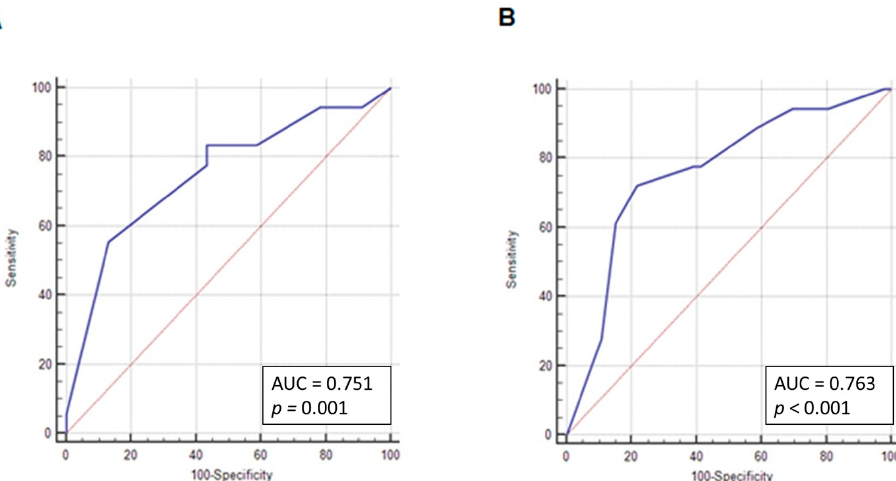
Figure 4. ROC curves for determining the CD133 cut-off value in tumor angioinvasion. ( A ) ROC curve for determining the CD133 nuclear localization cut-off value in tumor angioinvasion. Cut-off point > 80%; p = 0.001; AUC = 0.75; sensitivity = 55.6%; specificity = 87%. ( B ) ROC curve for determining CD133 localization in the plasma membrane cut-off value in tumor angioinvasion. Cut-off point ≤ 10%; p < 0.001; AUC = 0.76; sensitivity = 72.2%; specificity = 78.3%.